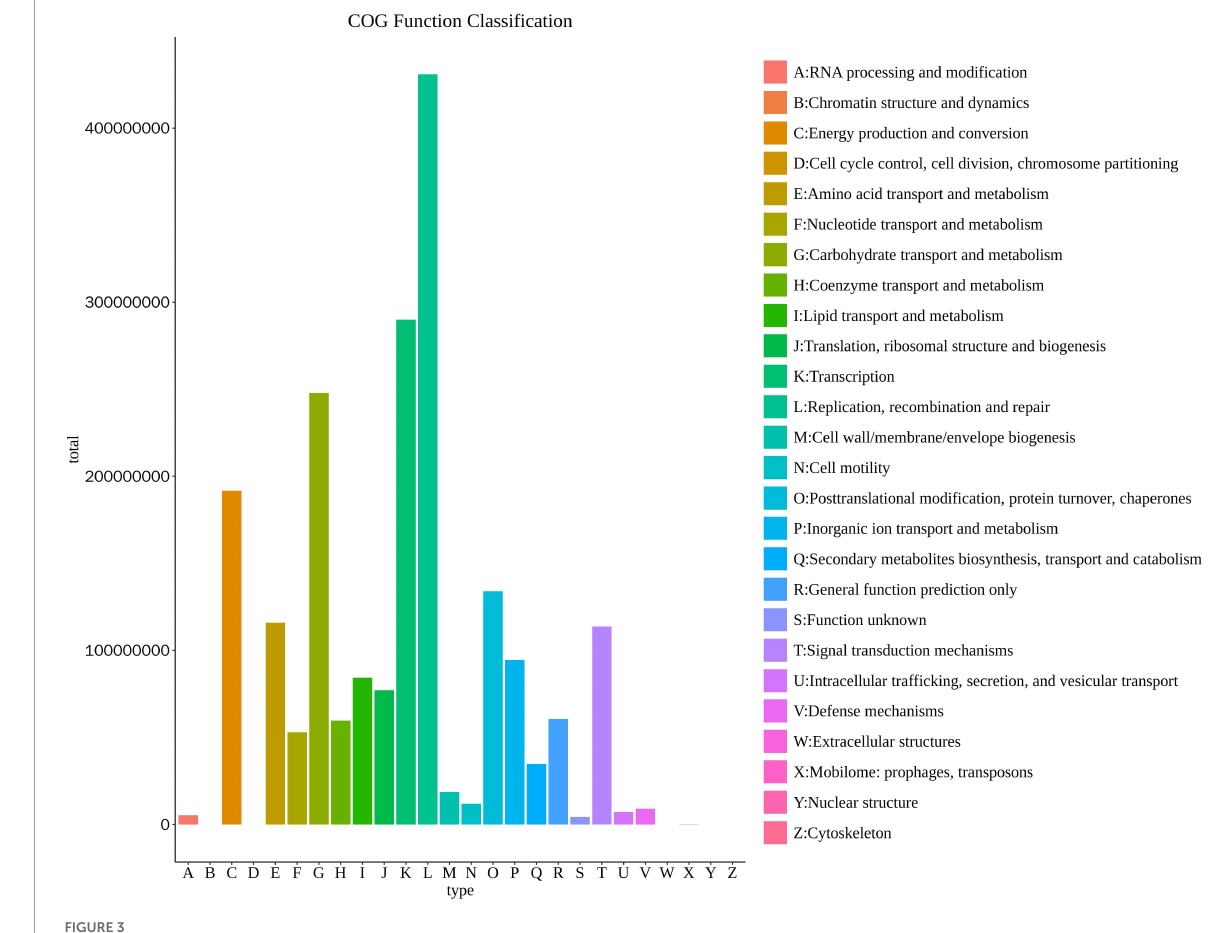
FIGURE3 COG function annotation classification histogram. The horizontal axis is the COG function annotation classification, and the vertical axis is the annotation